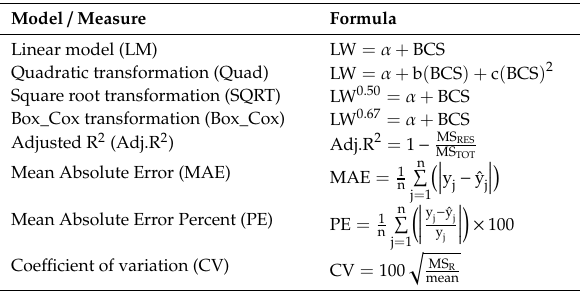
Table 1. Formulae for liveweight estimation models (linear model (SLM), quadratic transformation (QUAD), Box-Cox transformation (Box-Cox) and square root transformation (SQRT)) using body condition score (BCS), adjusted R 2 , error metrics (mean absolute error, MAE; percent error, PE) and coe ffi cient of variation of the liveweight